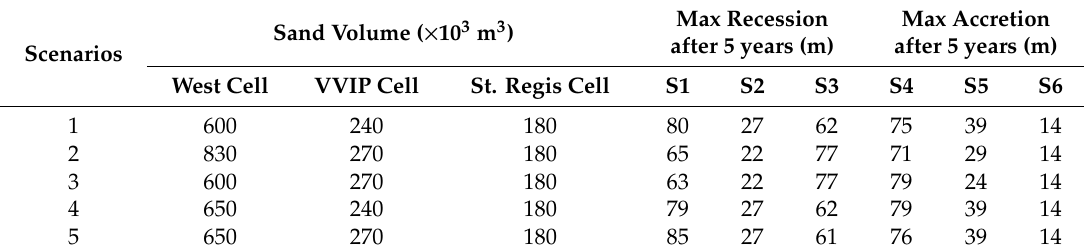
Table 5. Maximum accretion / erosion occurred after 5 years, for the proposed